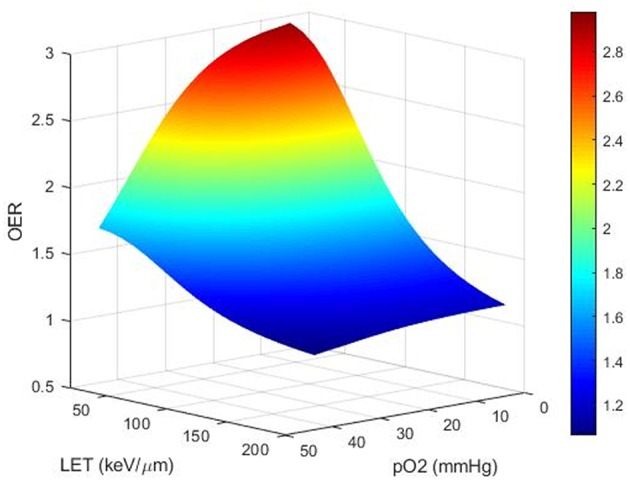
Theoretical computational modeling of the OER as a function of pO2 and LET (performed on MATLAB). OER increases nonlinearly with increasing degree of hypoxia and decreases with increasing LET. Compared to low-LET conventional RT (photons or protons), high-LET RT, over a few hundreds of keV/μm (carbons), is expected to be less sensitive to hypoxia and could be more efficient for treating hypoxic tumors.